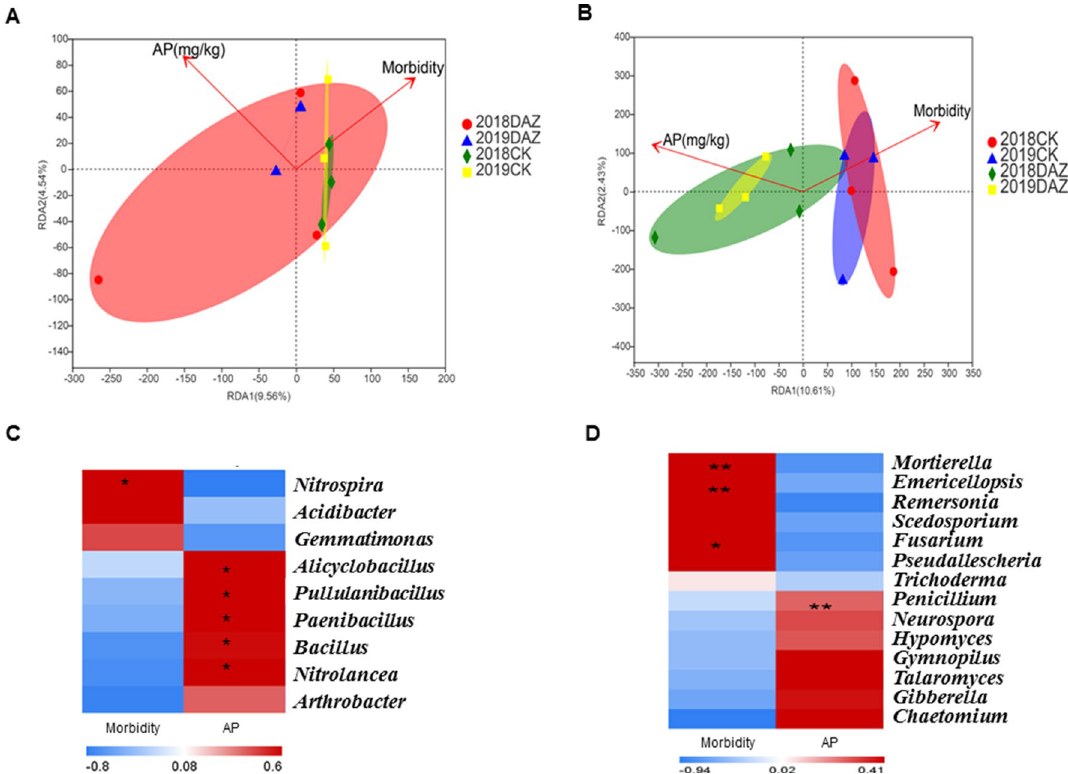
Figure 8. Correlation analysis of environmental factors. ( A ) RDA analysis on bacterial genus level. ( B ) RDA analysis on fungal genera level. ( C ) Spearman Correlation Heatmap of bacterial genera. ( D ) Spearman Correlation Heatmap of fungal genus. AP Available soil phosphorus. Red color represents highly positively correlated values; Blue color represents negatively correlated values. Means ± SD (n = 3). * 0.01 < P ≤ 0.05, ** 0.001 < P ≤